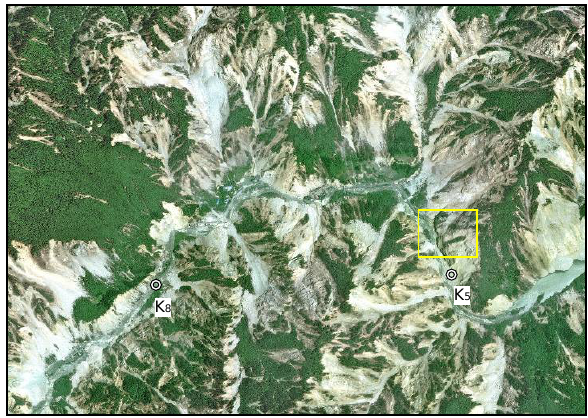
Fig. 5. Satellite image of loose deposits along PR303 shortly after the earthquake. Note: The detail of the marked part is shown in Fig. 6.